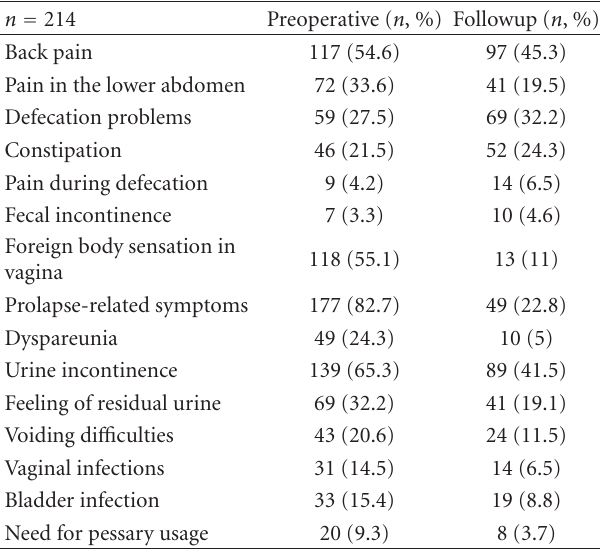
Table 2: Symptoms, preoperative and followup.